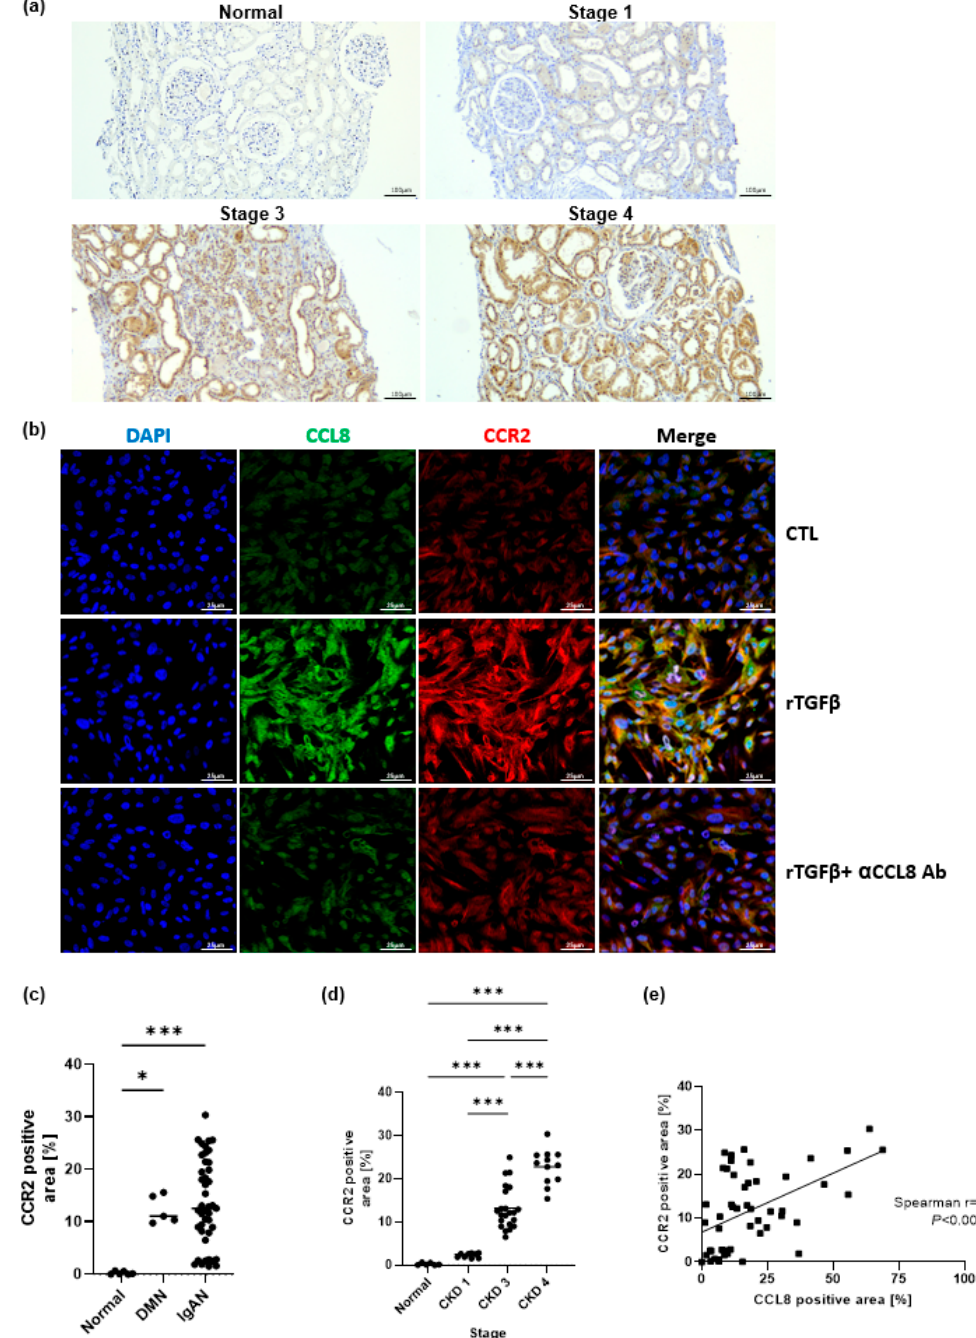
Figure 4. Representative photographs of kidney sections of healthy controls (HC), chronic kidney disease stage (CKD) 1, 3, and 4 of IgA nephropathy (IgAN) patients (original magnifications, Panel ( a ), ×100). CCR2 immunohistochemical analysis in patients with IgAN showed that CCR2-positive cells were predominantly located in the periglomerular and inflamed tubulointerstitium ( a ). After induction of fibrosis with rTGF- β in hTECs, the increased expression regions of CCL8 and CCR2 were correlated in immunofluorescence staining and alleviation of expression was also observed in both after blocking CCL8 (original magnifications, Panels b, ×400 ( b )). CCR2 expression levels were significantly higher in patients with IgAN and advanced CKD stages ( c , d ). The percentage of CCR2 positively correlated with that of the CCL8 ( e ). * p < 0.05, and *** p < 0.001.